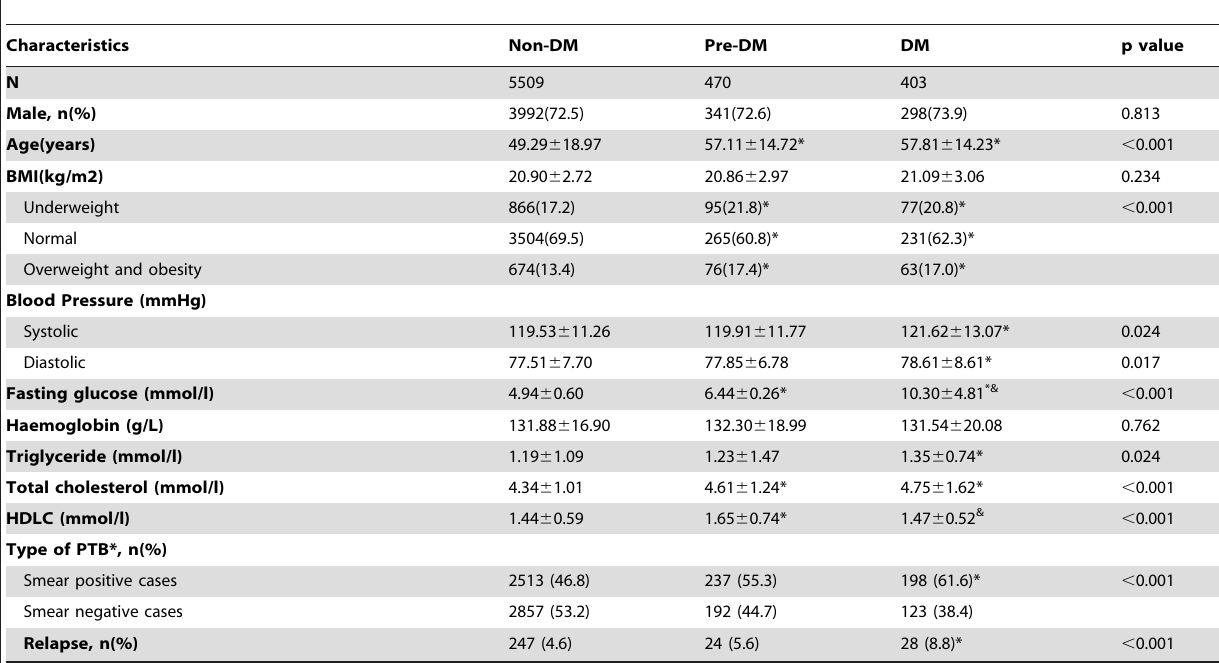
Table 3. Study characteristics of TB patients by diabetes status in Linyi, China, 2010–2012.